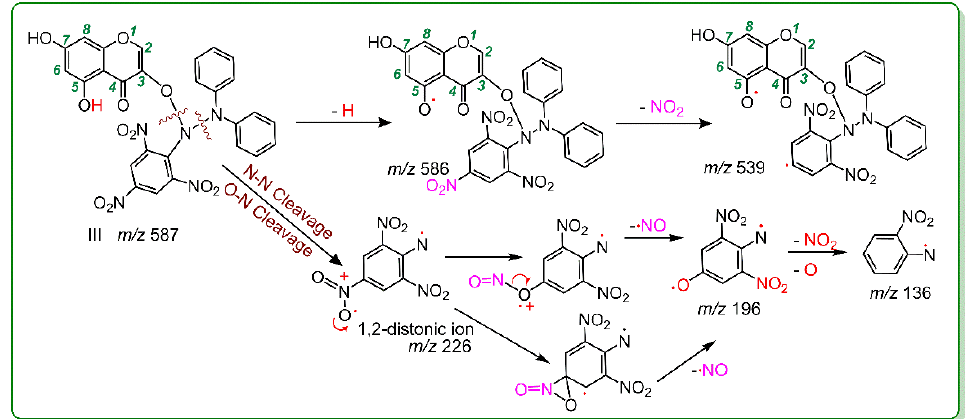
Figure 6. Proposed RAF product of 3,5,7-trihydroxychromone-DPPH adduct and its MS elucidation (Other linking sites between a 3,5,7-trihydroxychromone moiety and a DPPH moiety should not be excluded. Other reasonable cleavages should not be excluded in the MS elucidation.).